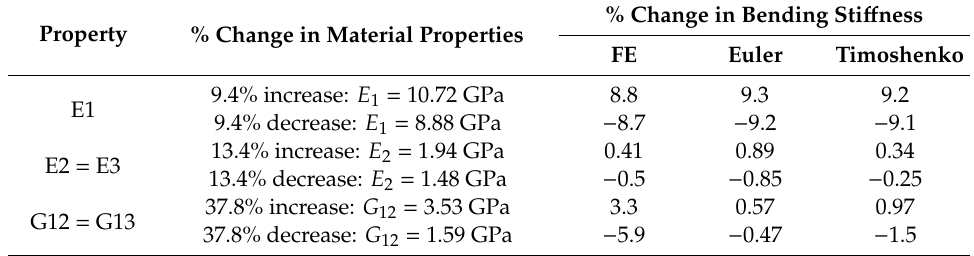
Table 4. Percent variation in the longitudinal bending sti ff ness of the sandwich panel caused by change in material